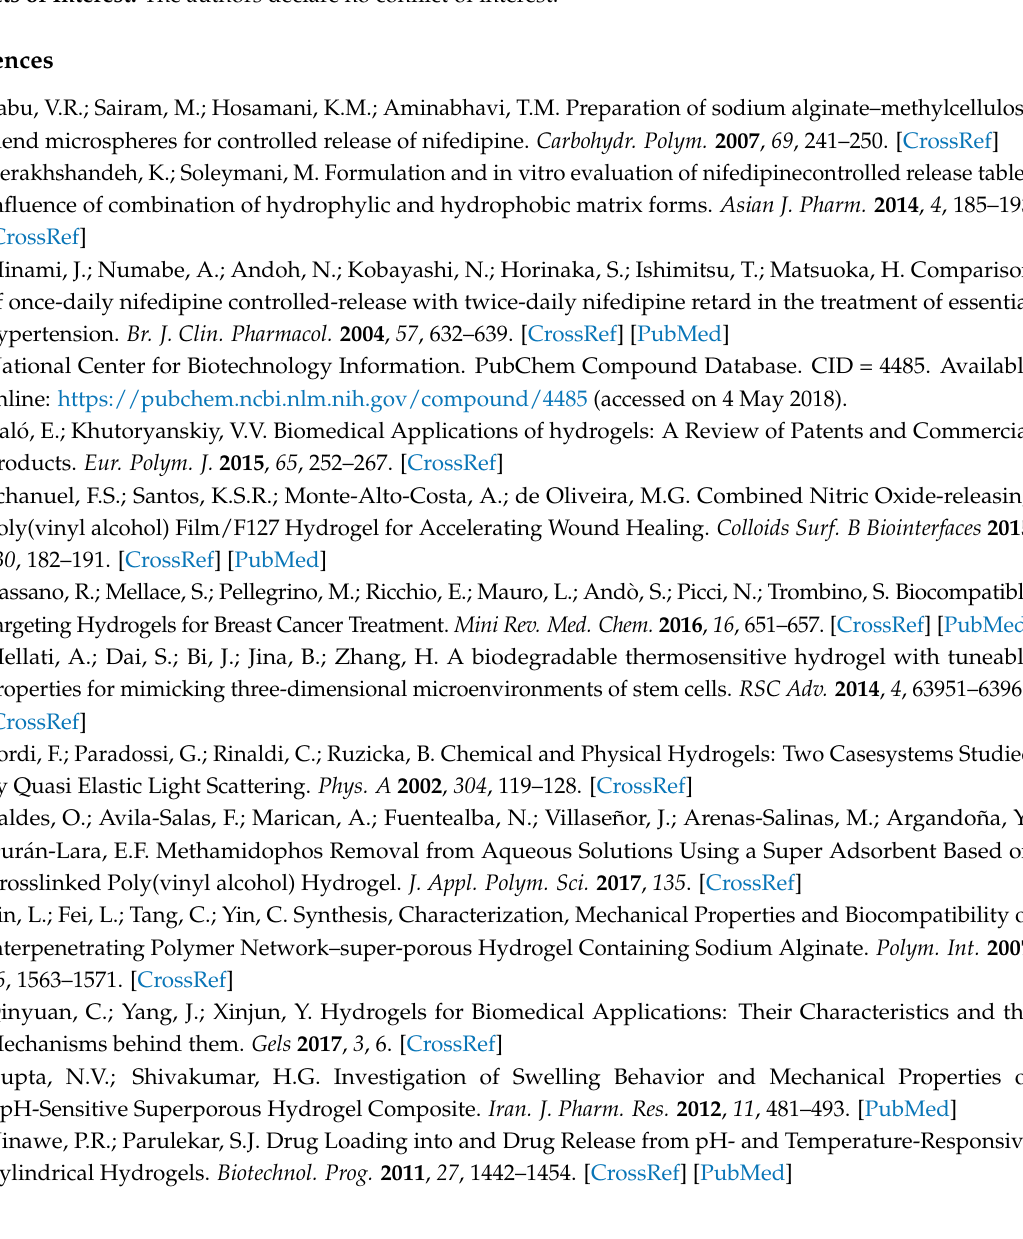
Figure S1: SASA and NFD retention plots, Script S1: TCL script to calculate the Radius of Gyration (RGYR), Script S2: TCL script to calculate the Solvent Accessible Surface Area (SASA), Script S3: TCL script to calculate the number of NFD molecules located within 5.5 Å of the